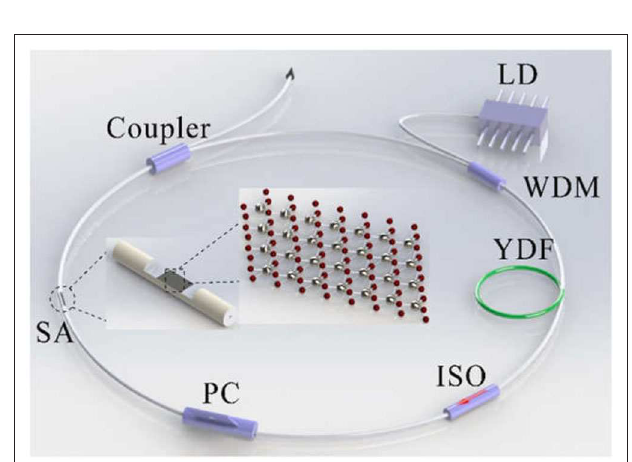
FIGURE 3 | Experimental setup of the few-layer NbSe 2 -based mode-locked Yb-doped fiber laser.